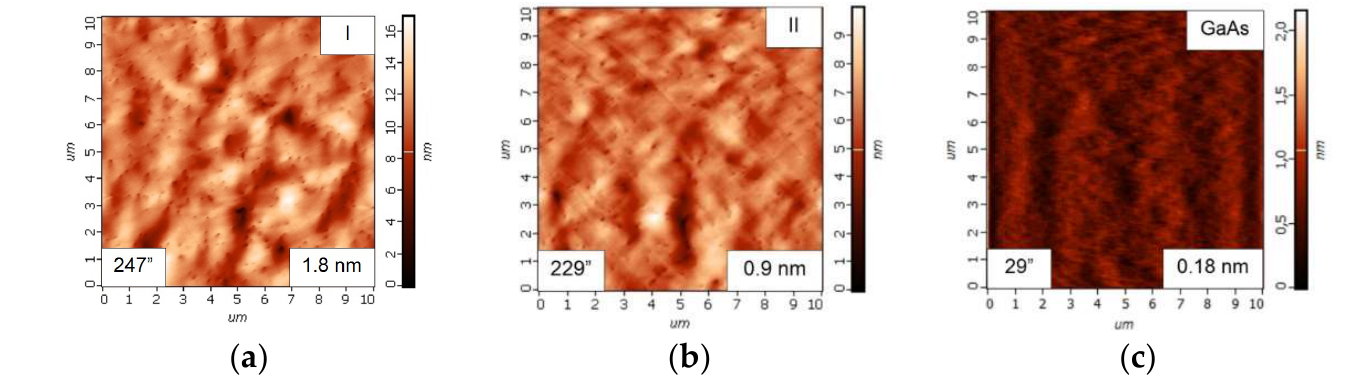
Figure 2. AFM images of the surface of GaAs/Si HSs I ( a ), II ( b ) and the test GaAs/GaAs structure ( c ). The root-mean-square surface roughness (RMS) and FWHM determined for the (004) peak ( W ) are shown in the bottom right and bottom left insets, respectively.